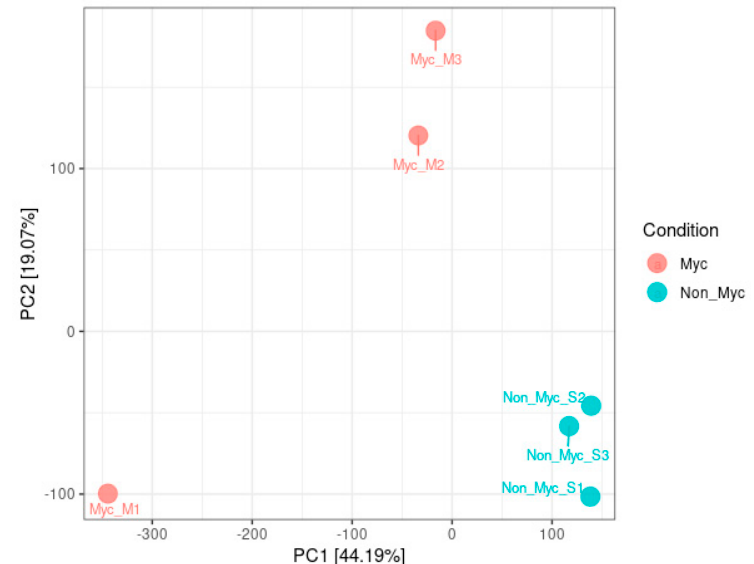
Figure 3. Principal Component Analysis (PCA) of the complete transcriptomes of the three biological replicates of mycorrhizal (Myc) and non-mycorrhizal (Non-Myc) root samples of Oeceoclades maculata.